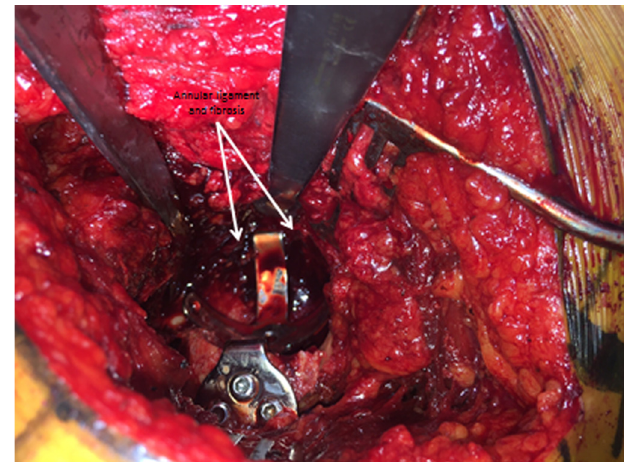
Figure 1. Annular ligament and fi brotic tissue are not removed.